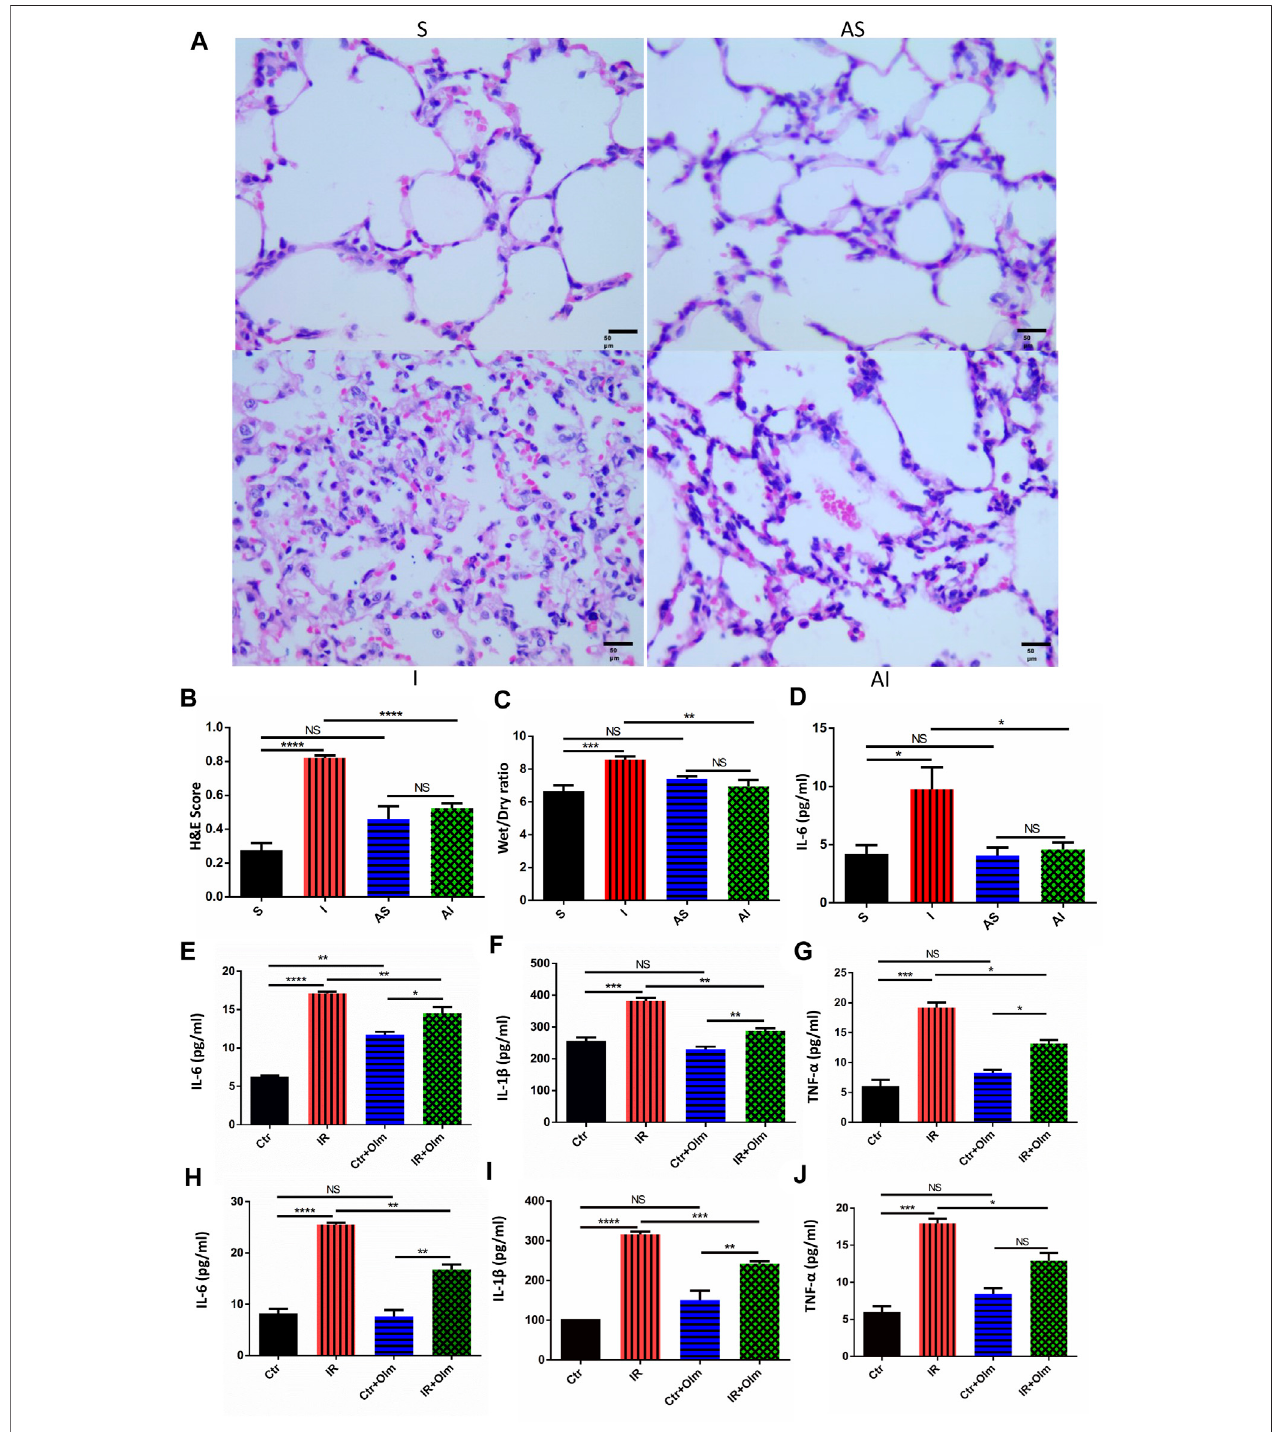
FIGURE 1 | Olmesartan (Olm) can attenuate single-lung ventilation (SLV) induced lung injury. Lung histopathological alterations in rats in the S (sham) group; AS (ARB +sham) group, inwhichtheratsgiven7 daysOlmtreatmentbeforethesham surgery;I(injury)group,inwhichtheratsunderwentSLVfor1 h(rightlungventilation and left lung collapsed) and double lungs ventilation for 3 h; and the AI (ARB + injury) group (hematoxylin and eosin staining; original magni fi cation, ×400) ( n = 6) (A) . The lung injuryscoreofHE staininginratsineach group (B) .LungW/Dratioinratsinallgroups (C) .IL-6inplasmaasshown byELISA (D) .QuantitativeanalysisofIL-6, IL-1 β andTNF- α inHUVECsculturesupernatantindifferentgroupsbyELISA (E – G) ( n =3).QuantitativeanalysisofIL-6,IL-1 β andTNF- α inA549cellculturesupernatant by ELISA (H – J) ( n = 3). Data are presented as the mean ± standard error ofthe mean. NS: not signi fi cantly different. * p < 0.05, ** p < 0.005, *** p < 0.001, **** p < 0.0001. SLV: single-lung ventilation; Olm: olmesartan; ARB: angiotensin receptor blocker; S: sham; AS: ARB + sham; I: injury; AI: ARB + injury; Ctr: control; IR: ischemia reperfusion; W/D: wet/dry ratio; IL-6: interleukin-6; IL-1 β : interleukin-1 β ; TNF- α : tumor necrosis factor- α ; ELISA: Enzyme-linked immunosorbent assay.